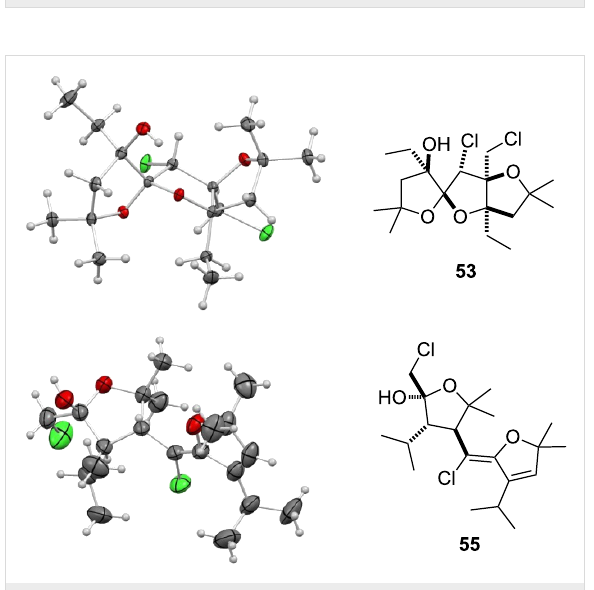
Figure 2: X-ray diffraction analysis of two new